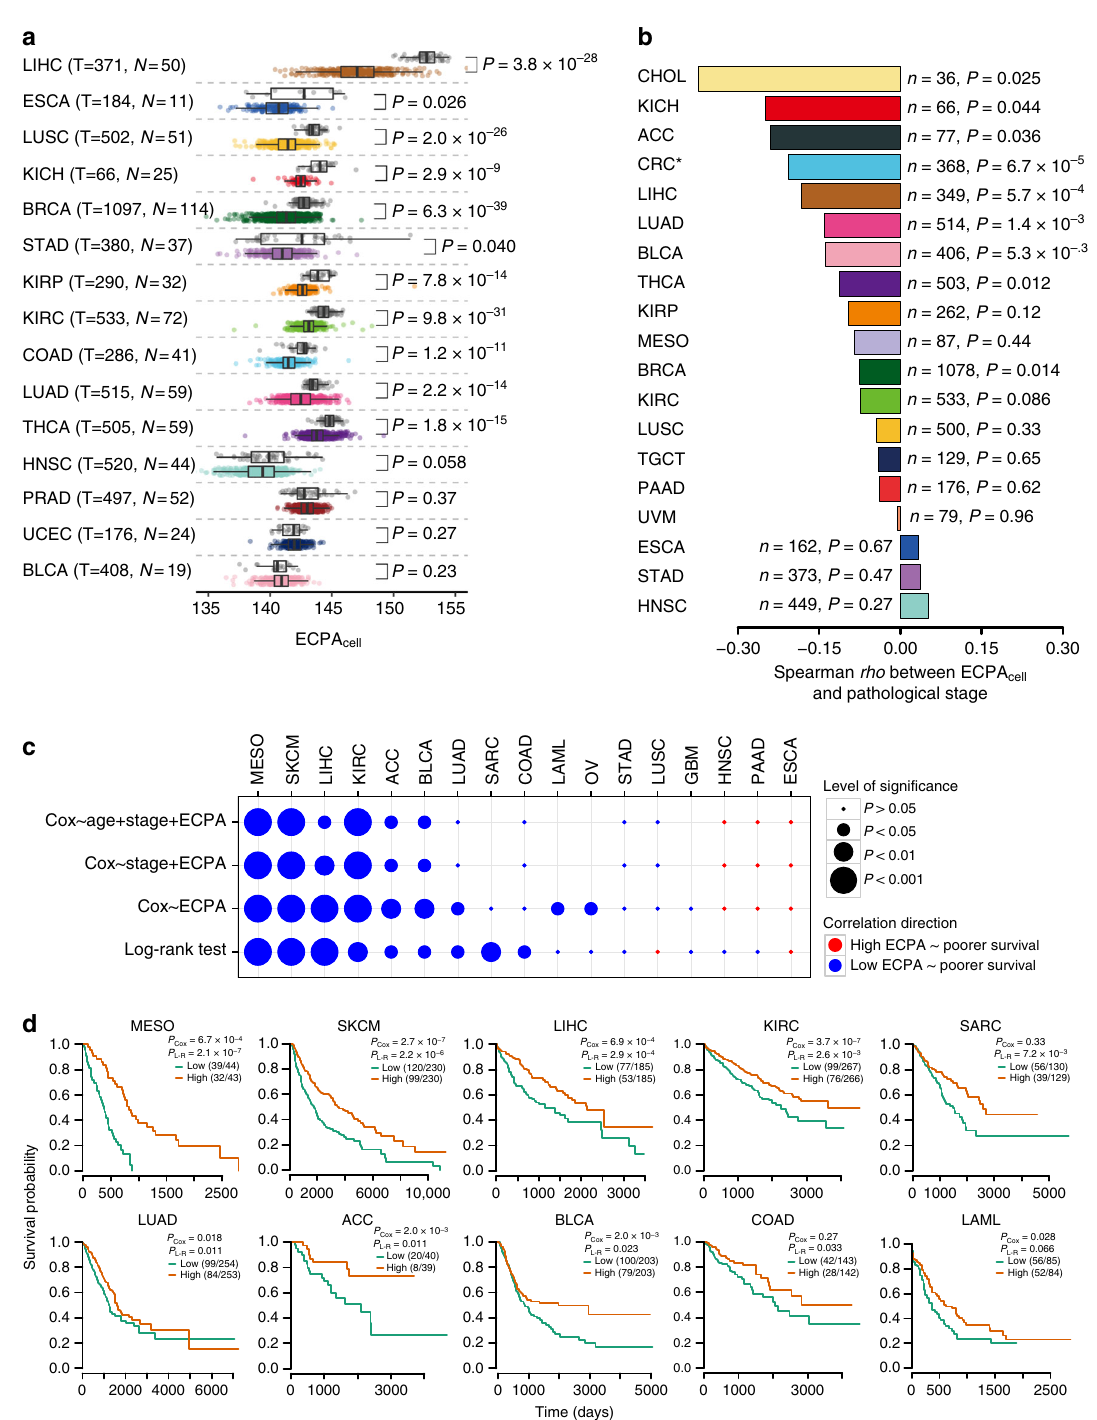
Fig. 4 Clinically relevant patterns of ECPA cell across cancer types. a Boxplot showing ECPA cell of tumor samples and matched normal tissue samples in 15 cancer types for which mRNA-Seq data of > 10 normal samples were available. The number of tumor samples (T), the number of normal samples (N), and Wilcoxon ’ s rank-sum test P -values are displayed in the plot. Center line, median; box limits, upper and lower quartiles; whiskers, 1.5 times the interquartile range. b Bar plot showing Spearman ’ s correlation coef fi cient of ECPA cell and the pathologic stage for patients with 19 cancer types. The numbers of tumor samples ( n ) and Spearman ’ s rank correlation P -values are displayed in the plot. *Colon and rectal adenocarcinoma are merged as colorectal carcinoma (CRC) in the analysis. c Associations between ECPA cell and the patients ’ survival times using either log-rank tests or Cox proportional hazards model in 17 cancer types that have ≥ 75 samples and ≥ 25% events. Sample size and results for additional cancer types are provided in Supplementary Fig. 11. Circle size indicates the signi fi cance of the correlation; color indicates correlation direction. d Kaplan – Meier plots showing the survival probability of patients with lower ECPA cell or higher ECPA cell in ten cancer types. For each cancer type, patients were divided into two equal groups based on ECPA cell of the patients ’ tumor samples. P -values of log-rank and univariate Cox tests are